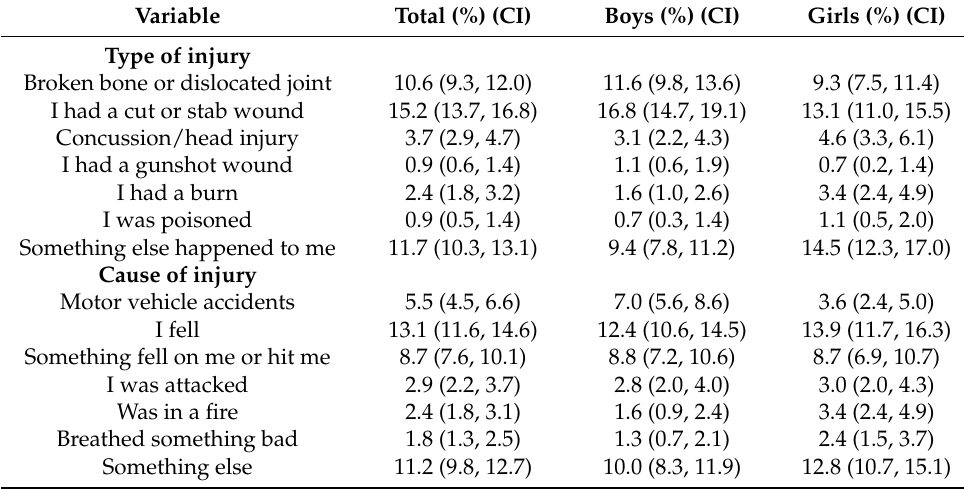
Table 3. Prevalence of injury events by sex.